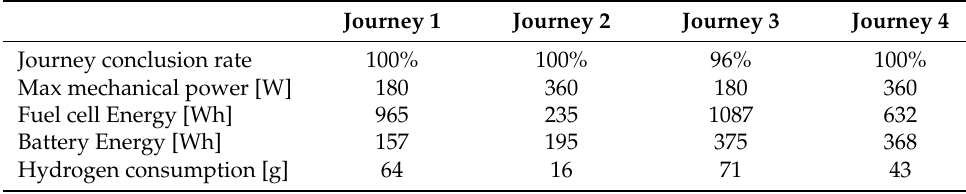
Table 7. AMV achieved performance in the four analyzed